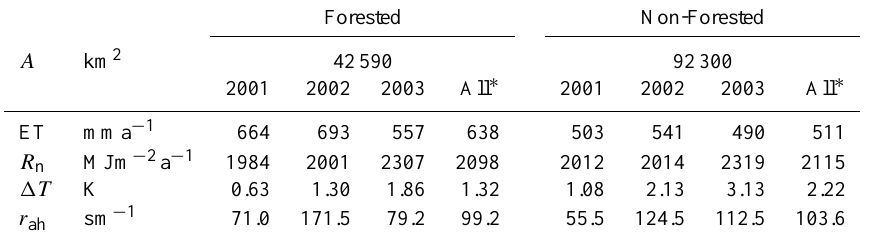
Table 1. General results of the evapotranspiration calculation. The total area (134890km 2 ) is the modelled part of the Elbe River basin as shown in Figs. 9–11. ET and R n are SWIM calculations, 1T and r ah are derived on that basis from the LST maps. Forested Non-Forested km 2 42590